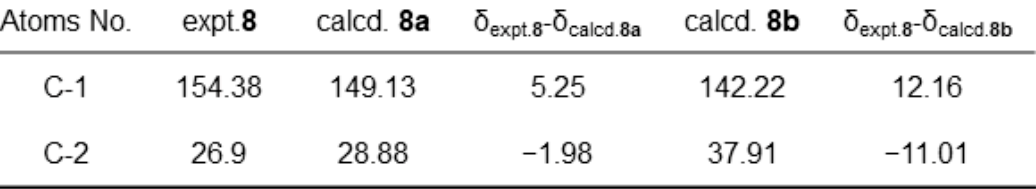
Figure 5. The possible conformers ( A ), their energy values ( A ) and the calculated 13 C-NMR data ( B ) for N-nitrosamines of 8.